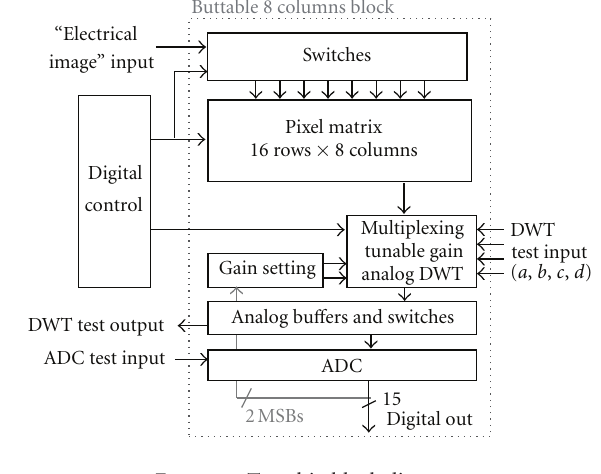
Figure 5: Test chip block diagram.